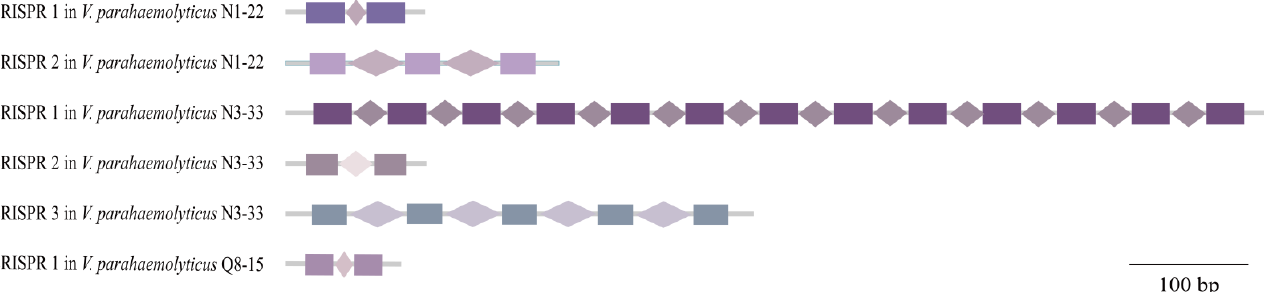
Figure 8. The structural features of CRISPRs identified in the V. parahaemolyticus genomes. The re- peat sequences were shown by the rectangle of different colors and the spacer regions were repre- sented by rhombuses of different colors.